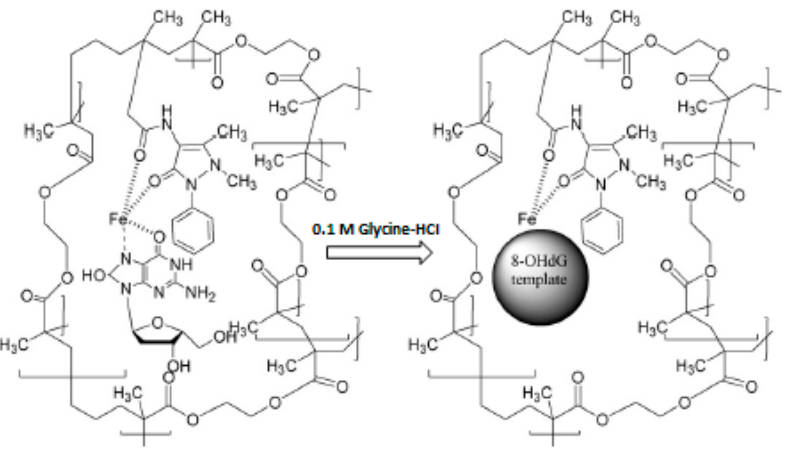
Figure 7. Preparation of MIP for 8-OHdG (reproduced with permission from [36]).